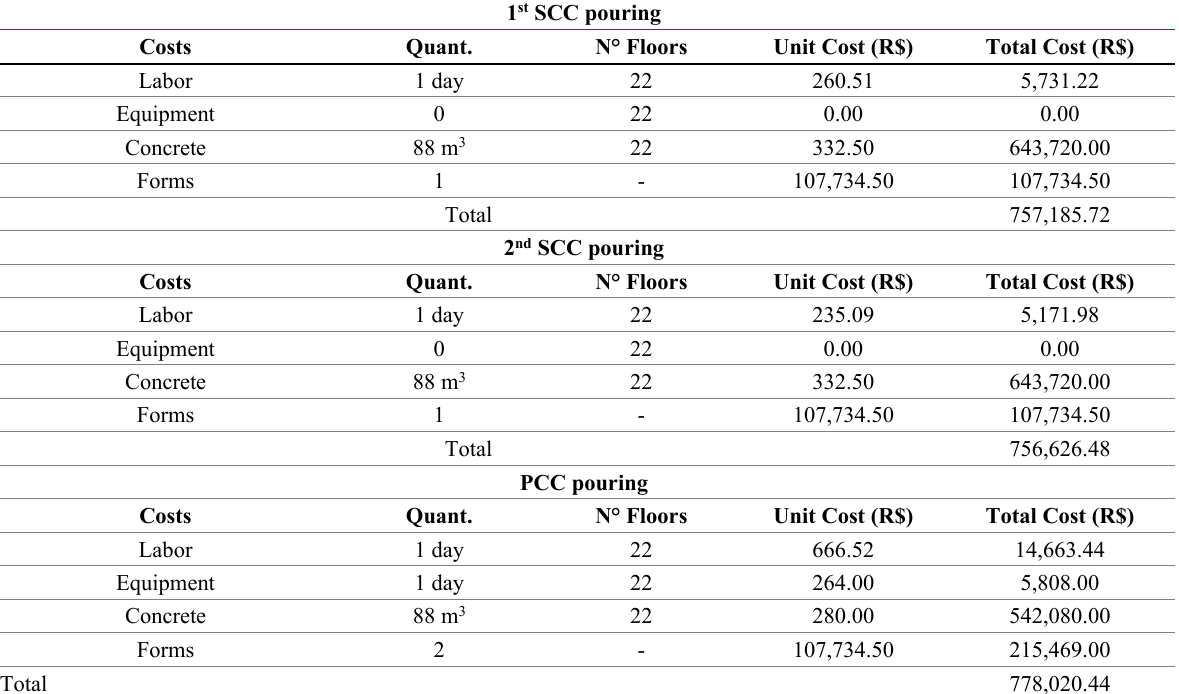
Table 10. Comparison between the total cost of SCC and